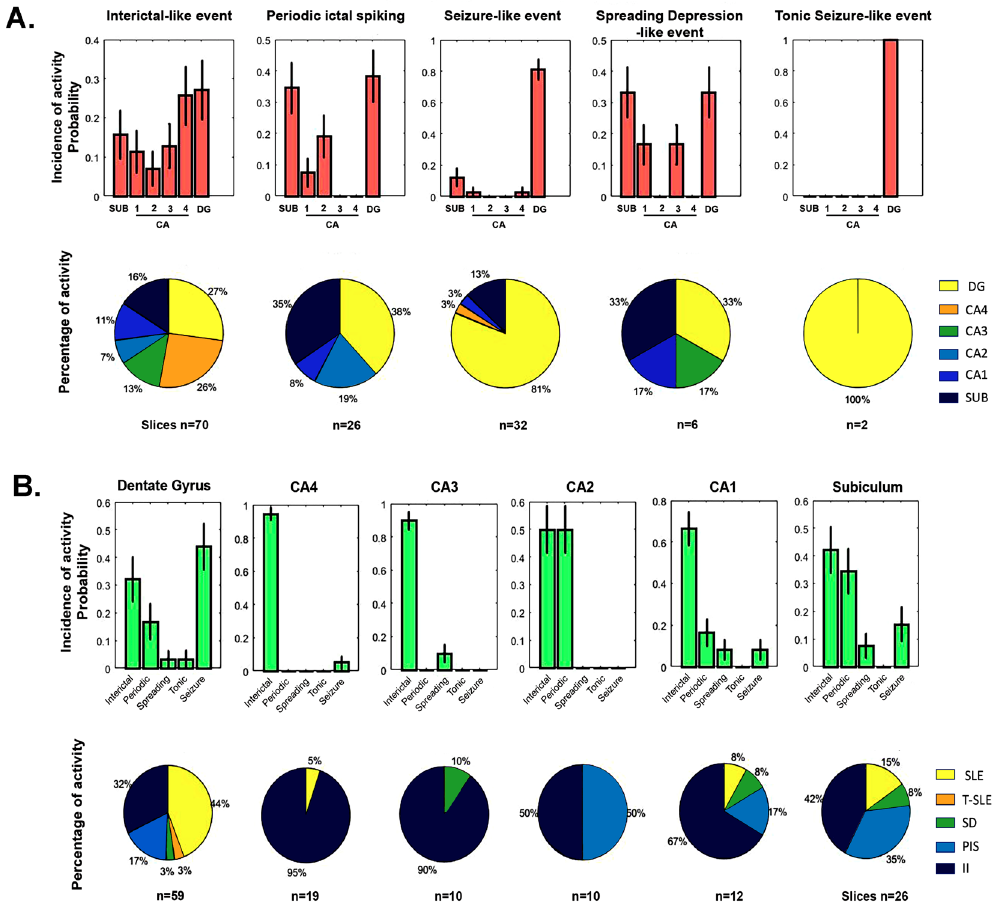
Figure 2. Distribution of epileptiform activity. ( A ) Conditional probability distribution of generated specific epileptiform-like activity within the hippocampal subfields P (epileptiform activity|hippocampal area). ( B ) Conditional probability distribution of specific hippocampal formation area to generate epileptiform activity P (hippocampal area|epileptiform activity). Bar graphs represent the mean probability with the corresponding standard deviation. Circular graphs represent the absolute frequencies. SLE: Seizure-like events; T-SLE: Tonic seizure-like events; SD: Spreading depression-like events; PIS: Periodic ictal spiking; II: interictal-like